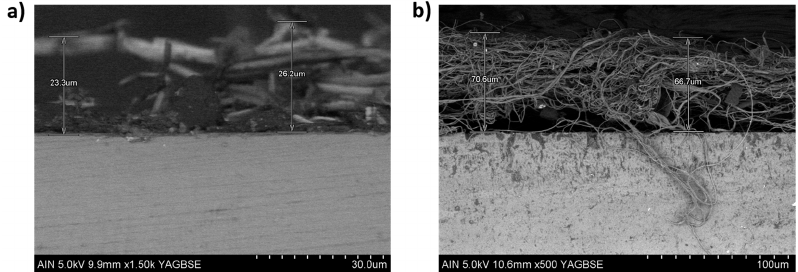
Figure 4. 2D-AFM images for a dimension of 60 × 60 µm 2 of the PS electrospun fibers ( a , b ) and PVC electrospun fibers ( c , d ) with their corresponding profiles.